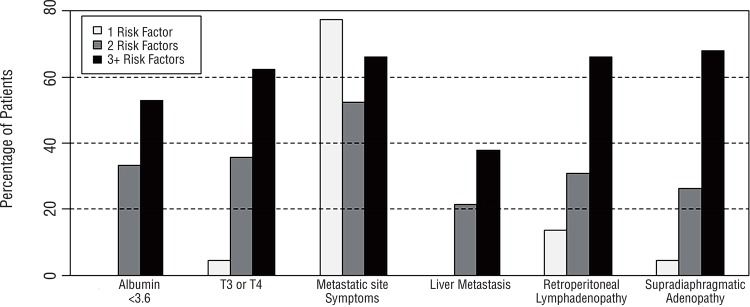
Distribution of individual risk factors among patients stratified by total number of risk factors present.